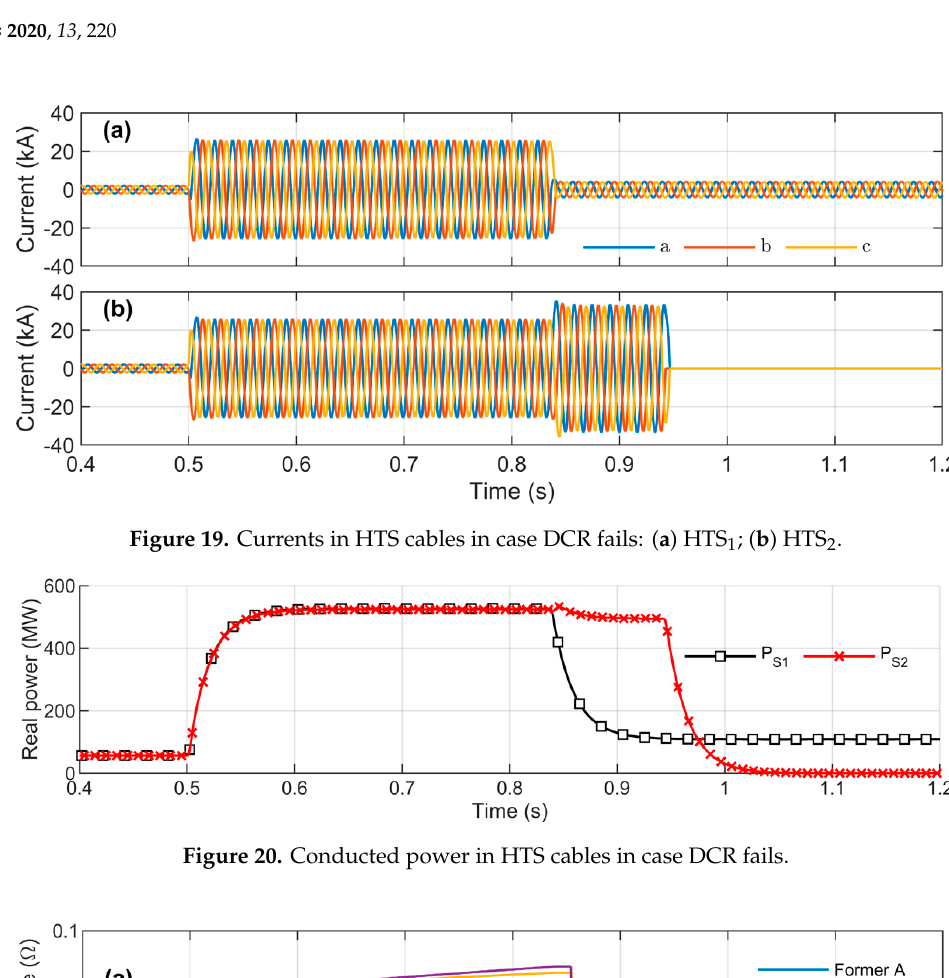
1 and the increase of current and power in HTS 2 . The fault is completely